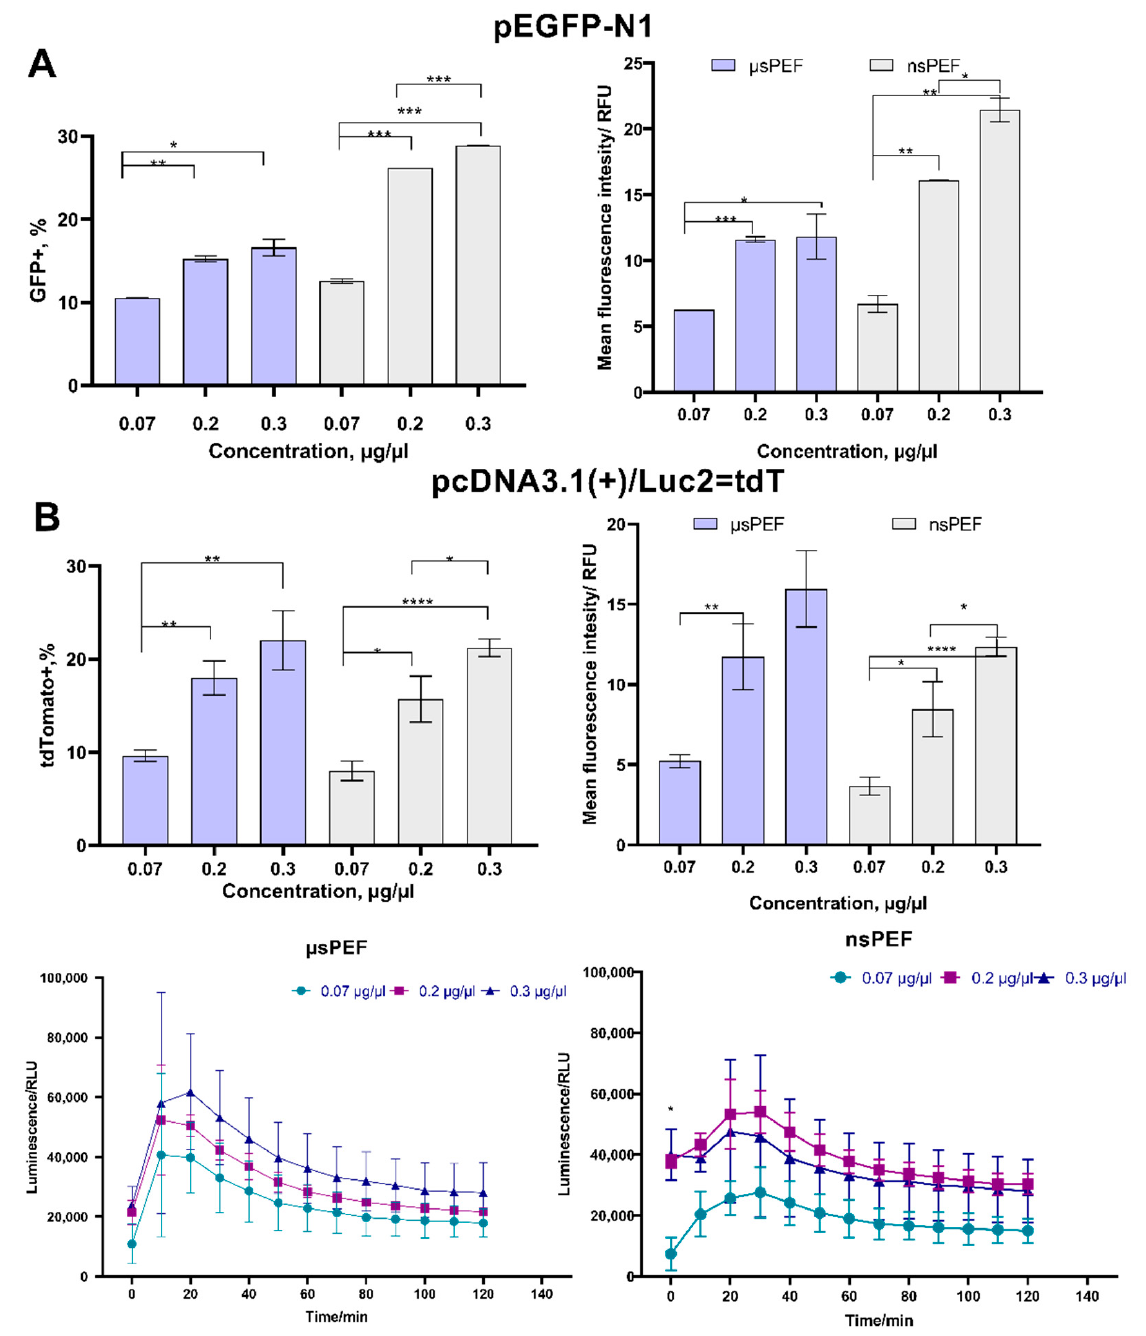
Figure 4. Transfection efficiency of murine 4T1 cell line during microsecond and nanosecond electroporation, using ( A ) pEGFP-N1 plasmid and ( B ) pcDNA3.1(+)/Luc2 = tdT plasmid. The MFI was normalized to negative control. Asterisk (*) corresponds to statistically significant differ- ence ( p <